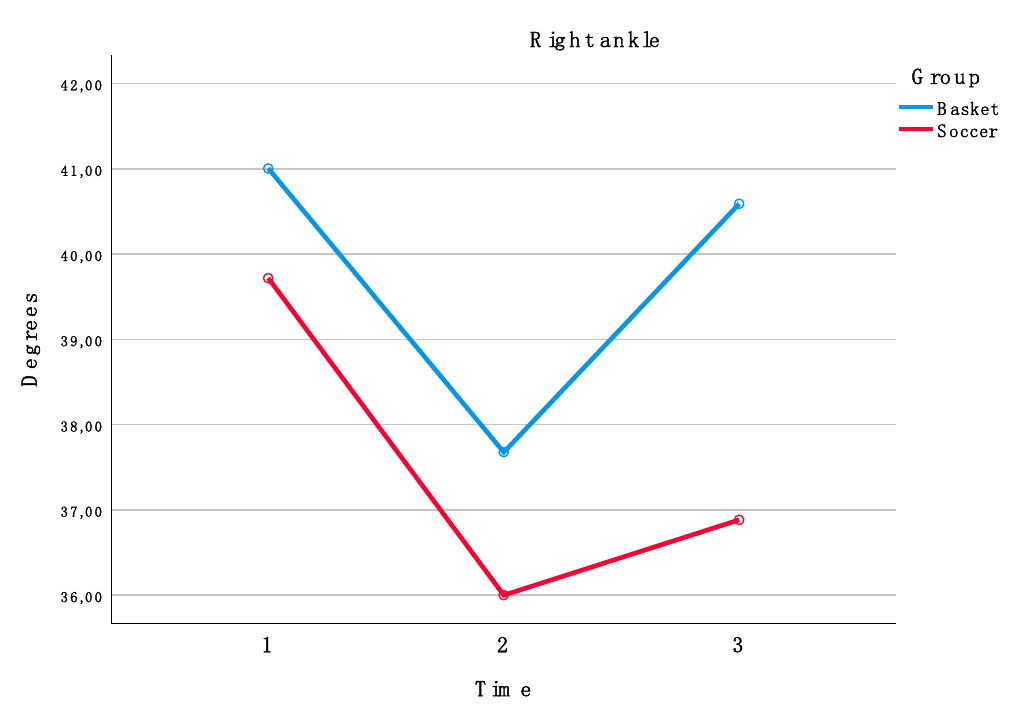
Figure 1. Right ankle ROM values for each group in three measurement times.